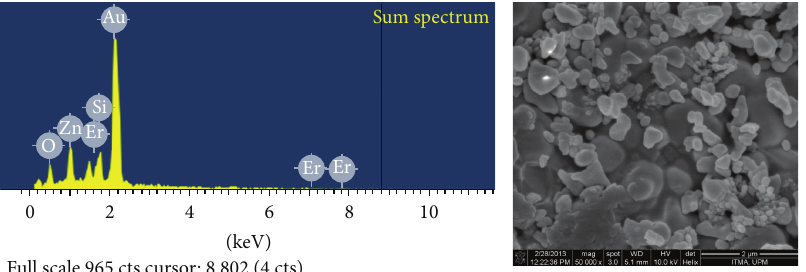
Figure 5: FESEM-EDX analysis of the distribution of Er 3+ in the willemite-based glass-ceramic doped with 3 wt% Er 3+ and sintered at the temperature of 900 ∘